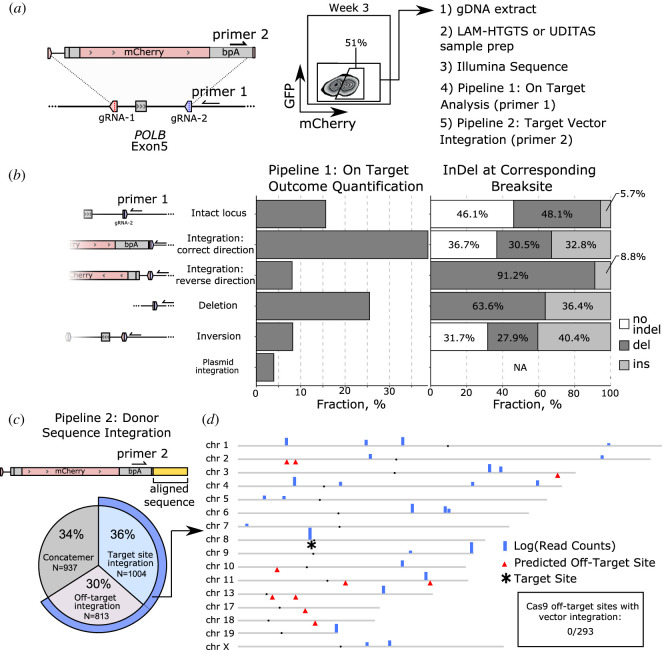
Linear amplification analysis of POLB exon 5; quantifying on-target Replace outcomes and mapping donor sequence integration. (a) Replace overview showing primer binding used for linear amplification. Unsorted gDNA was amplified with primer 1 or primer 2 and a universal primer, sequenced using Illumina technology, and analysed. (b) Pipeline 1 analysis of Uditas prepared samples quantifies outcomes at the targeted site with the corresponding InDels quantification. (c) Pipeline 2 analysis of UDiTaS prepared samples shows mCherry integration with an overall quantification of donor sequence integration. (d) Donor sequence integration mapped across the genome with read counts plotted logarithmically. Chromosomes with no integration sites were removed. Top 10 predicted Cas9 off-target sites shown with red triangles. The POLB locus on chromosome (chr) 8 is marked by an asterisk.